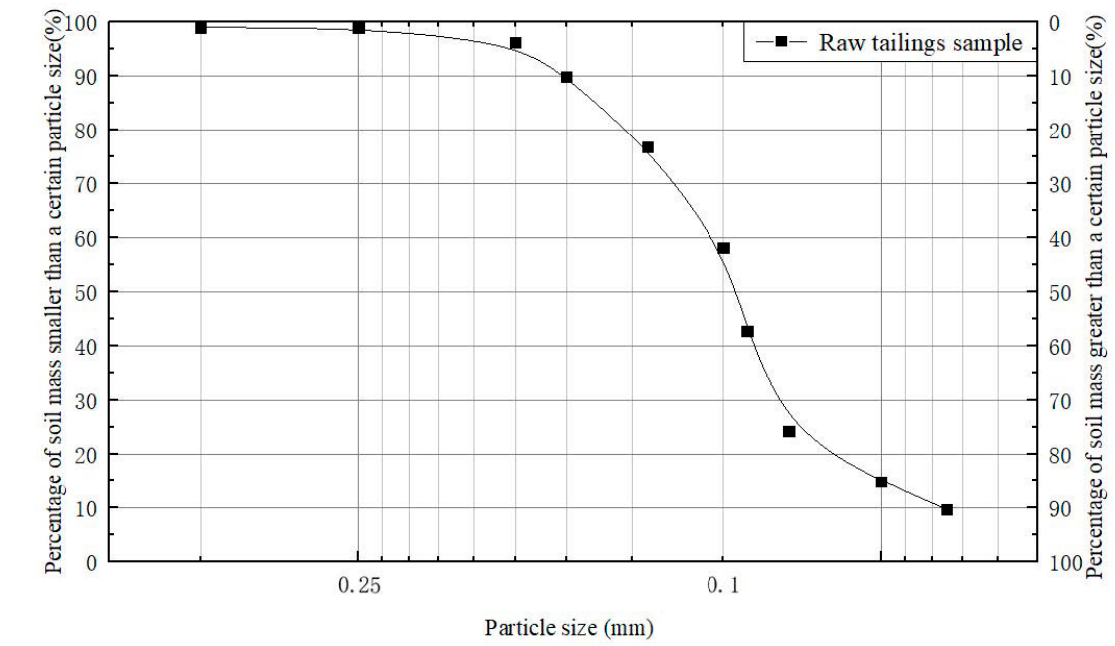
Figure 2. Particle size distribution curve of raw tailings sample.